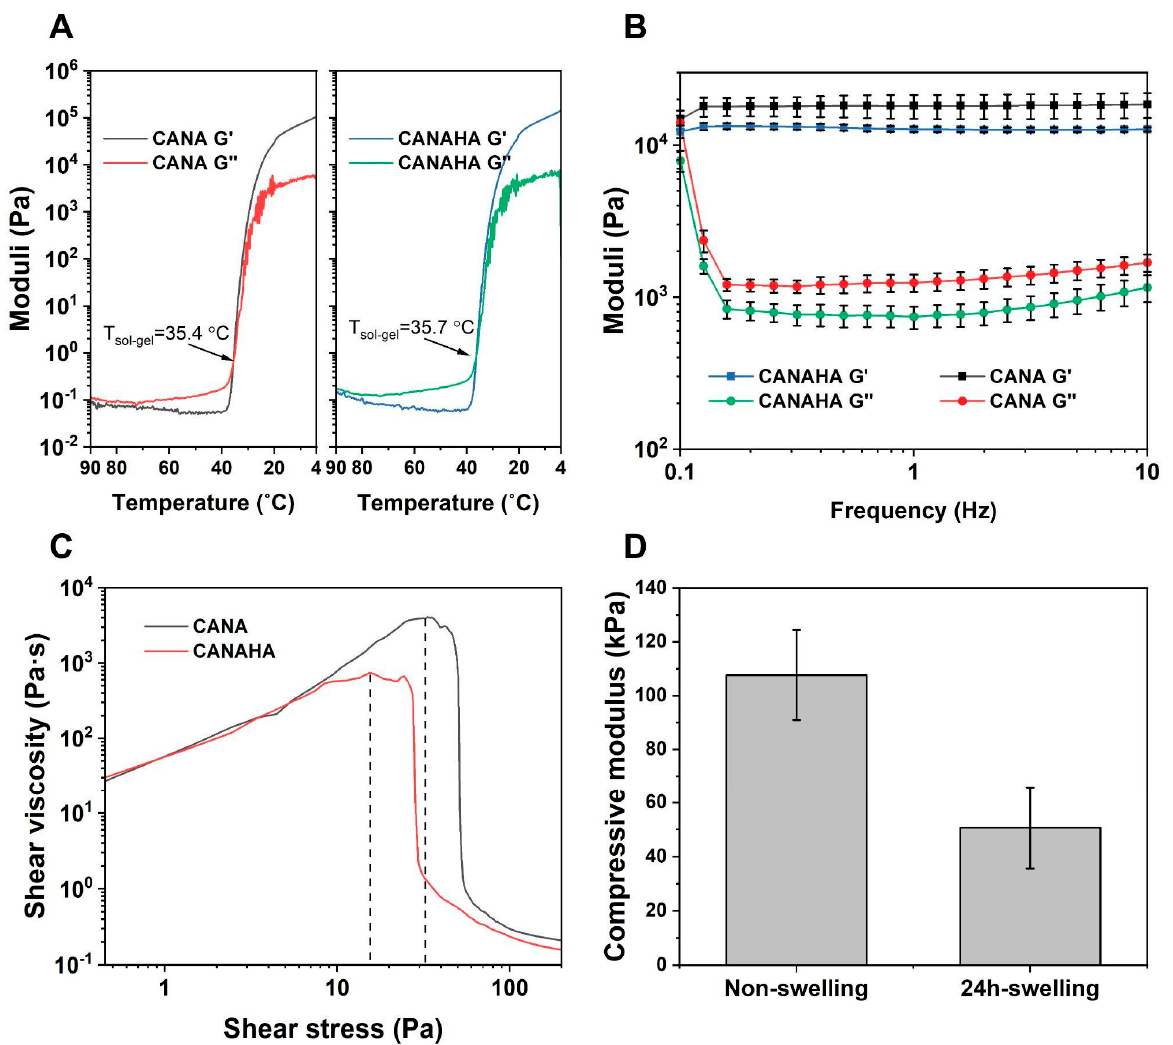
Figure 7. Rheological characterization of CANAHA bioinks. ( A ) Storage modulus (G’) and loss modulus (G’’) of bioinks as a function of temperature. ( B ) Storage and loss moduli of bioinks at printing temperature (37 °C) under oscillatory frequency sweep from 0.1 Hz to 10 Hz. ( C ) Yield stress of bioinks at 37 °C. ( D ) Compressive moduli of molded CANAHA discs before and after swelling.